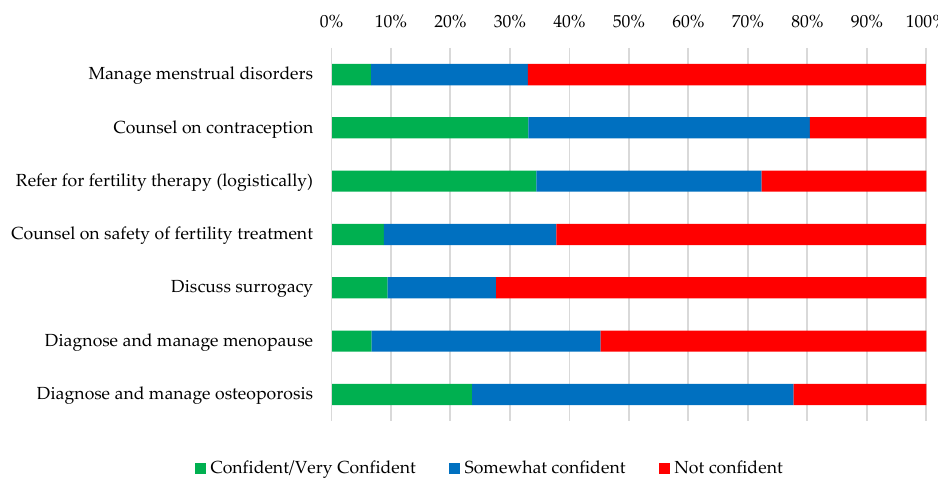
Figure 4. Nephrologists’ confidence managing common women’s health issues.